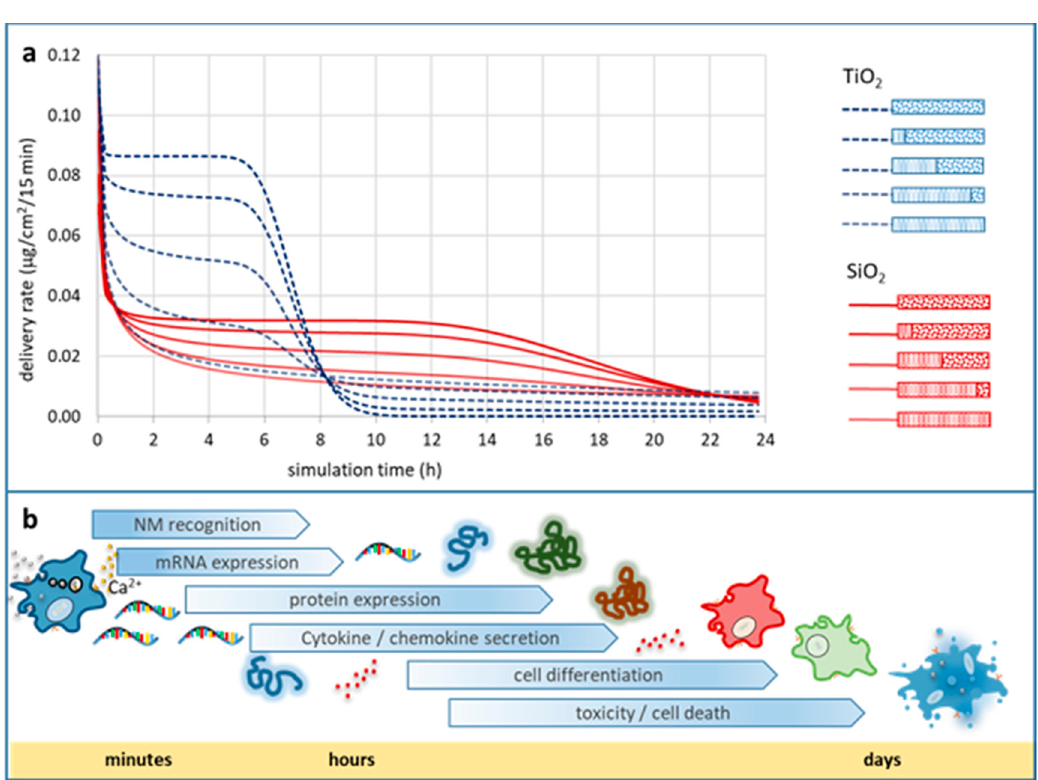
Figure 9. Impact of NP agglomeration on delivery rate in relation to the kinetics of biological responses (endpoints) typically monitored by in vitro experimentation using adherent cells. ( a ) Dependence of the delivery rate on NP/agglomerate density depicted for different mixtures. All parameters unchanged from Figure 8. ( b ) Time spans of typical biological readouts.